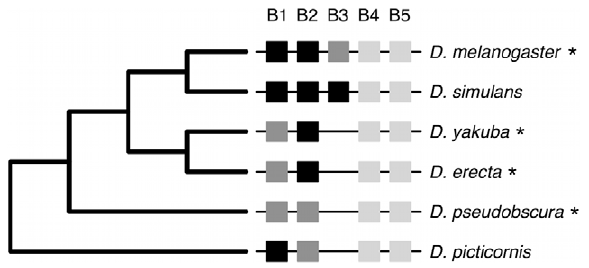
Figure 1. Evolution of the bcd binding sites in the eve stripe 2 enhancer in Drosophila . Phylogenetic relationships among 6 species of Drosophila [69] and bcd binding sites in their stripe 2 enhancers [3]. Squares represent the five binding sites (B1–B5) found in different species. The darkness of the square represents the closeness of the match between the binding site and the consensus bcd recognition sequence [30]: black, 8/9 nucleotides; dark gray, 7/9; light gray, ƒ 6/9. The stripe 2 enhancers of species marked with an asterisk were able to drive reporter gene expression in D. melanogaster embryos coincident with native eve stripe 2